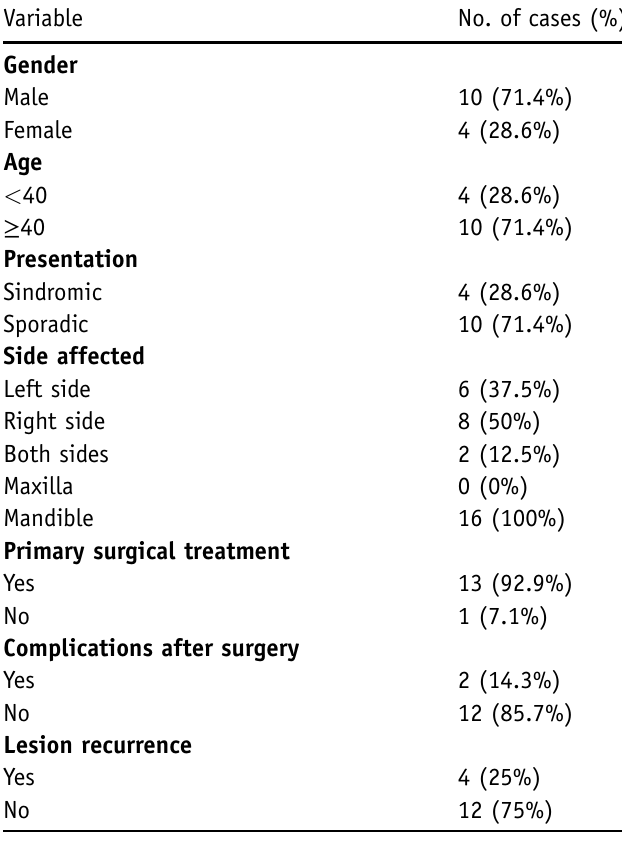
Table I. Demographic, clinical and surgical data of patients affectes by OKCs.